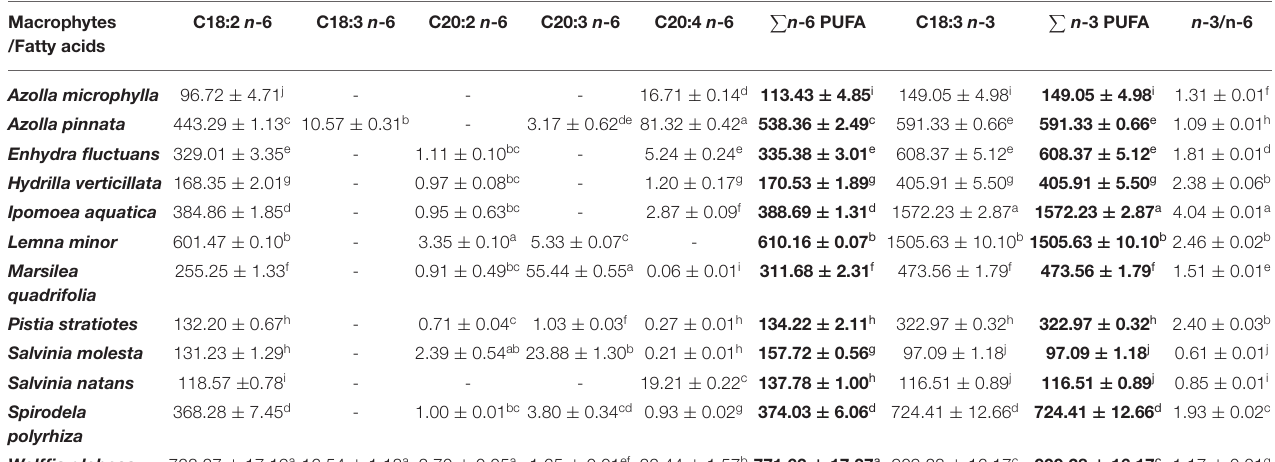
TABLE 3 | Polyunsaturated fatty acids (PUFA) profiles of freshwater macrophytes cultured with organic manures (mg/100g, dry weight). Macrophytes /Fatty